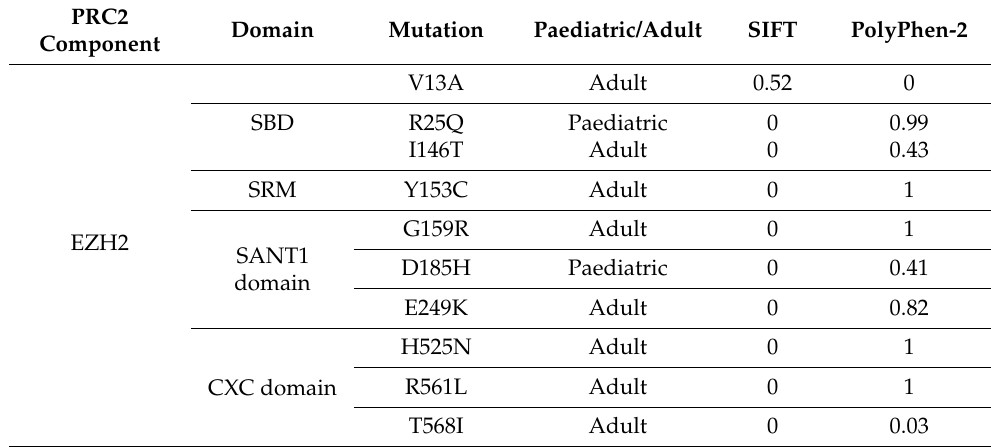
Table 1. Missense mutations in PRC2 core components in AML studies. Information was extracted from COSMIC, TARGET and PCGP datasets within the PeCan Data Portal [41] and the ELAM02 dataset [24,36] and whether the mutation was detected in a paediatric or adult cohort or in both is indicated in the fourth column in the table. Predictions of functional consequences by the SIFT [46] (higher score = more impaired function) and PolyPhen-2 [47] (lower score = more impaired function) algorithms are provided for these mutations. Functionally important regions of the core PRC2 proteins- CXC and SET (of EZH2), VEFS (of SUZ12) and WD domains of EED and RBBP4 harbour multiple mutations and include hotspot residues of typically varying allele